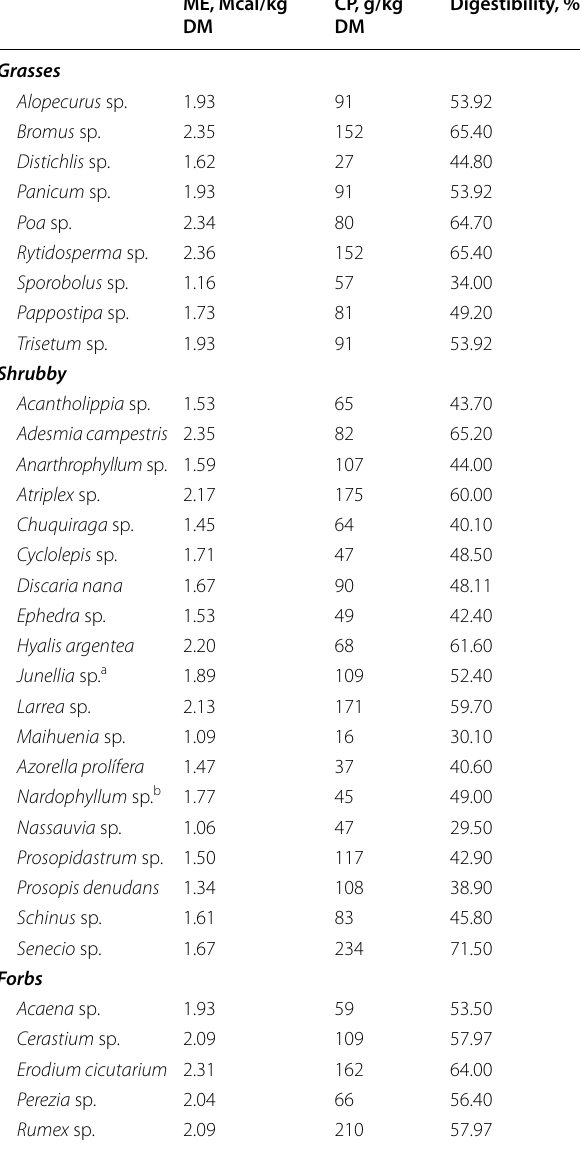
Table 1 Forage quality: metabolizable energy, crude protein and digestible dry matter of forage calculated from the diet botanical composition of pregnant